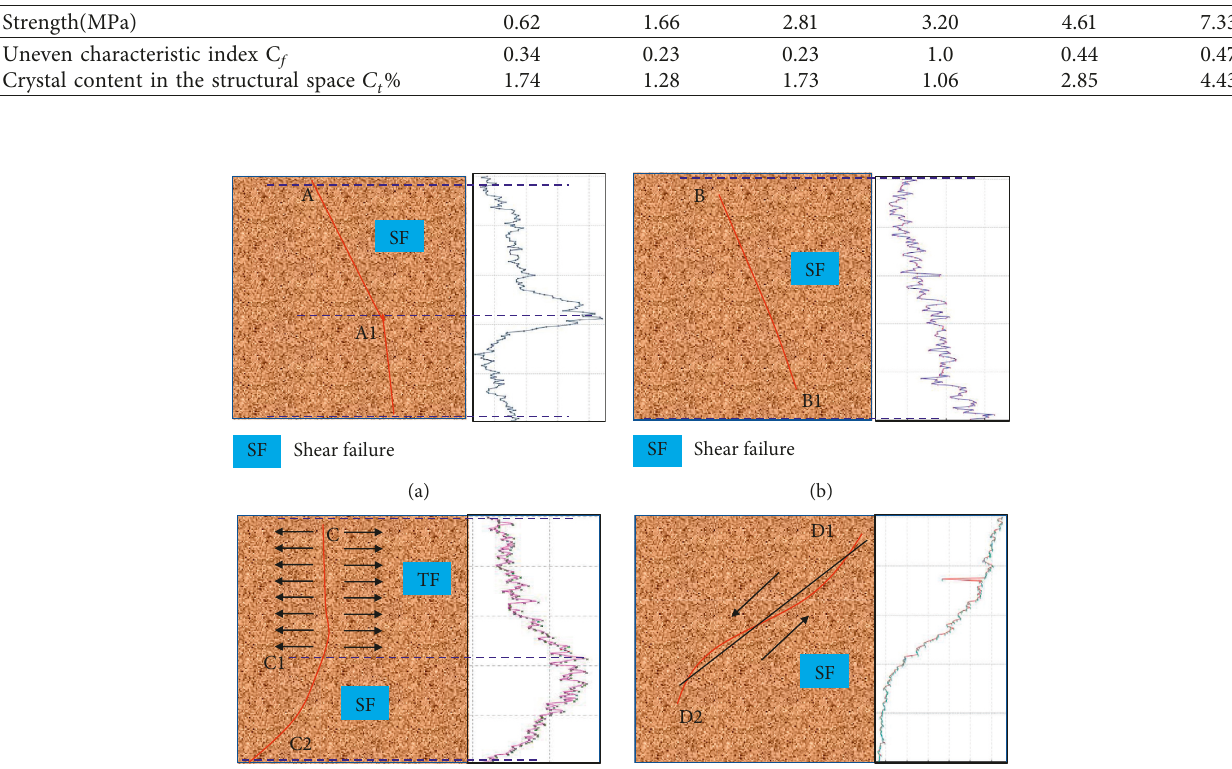
Table 4: Index parameter results under different strengths.